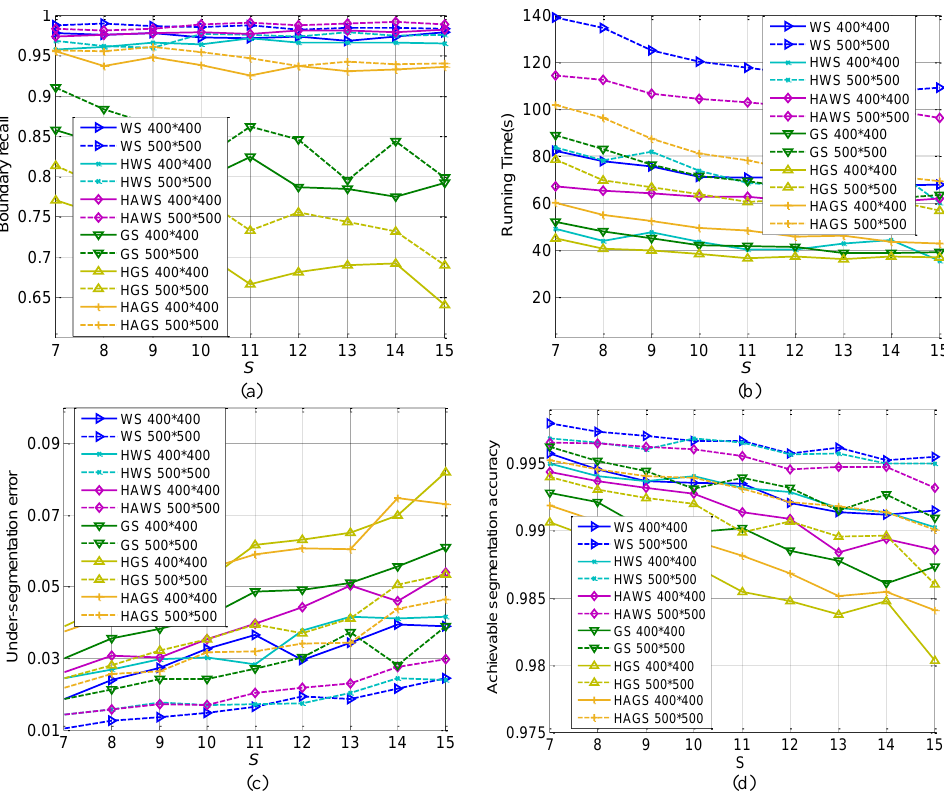
Figure 9. Quantitative evaluation results of different initializations based on two simulated data sets. ( a ) BR. ( b ) RT(s). ( c ) USE. ( d )